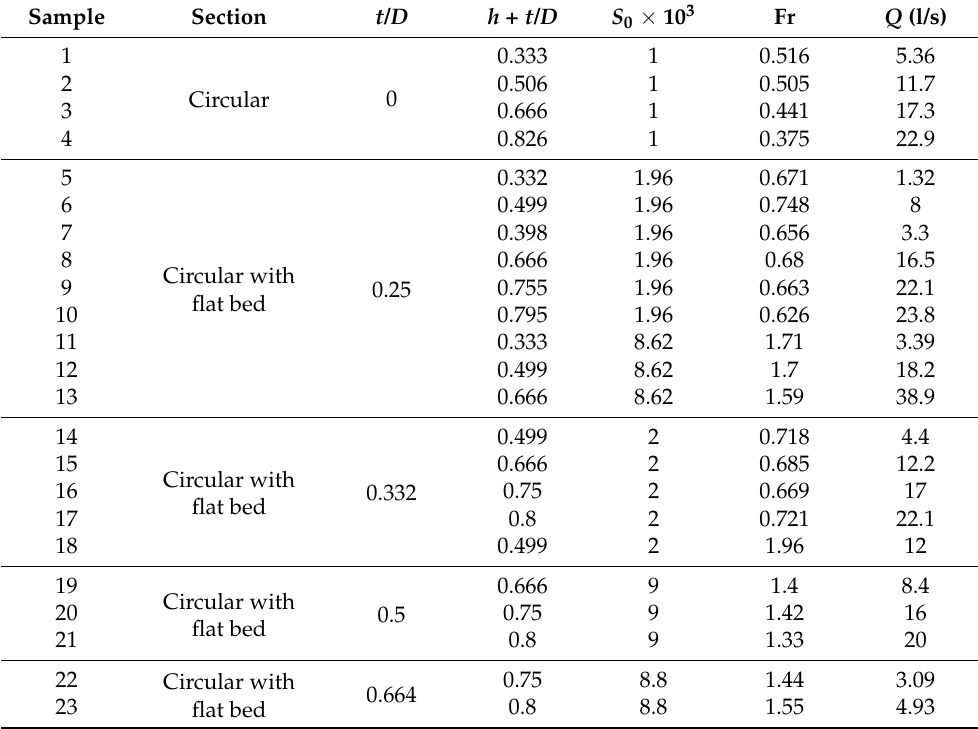
Table 1. Summary of the hydraulic parameters in the circular channel with and without sediment